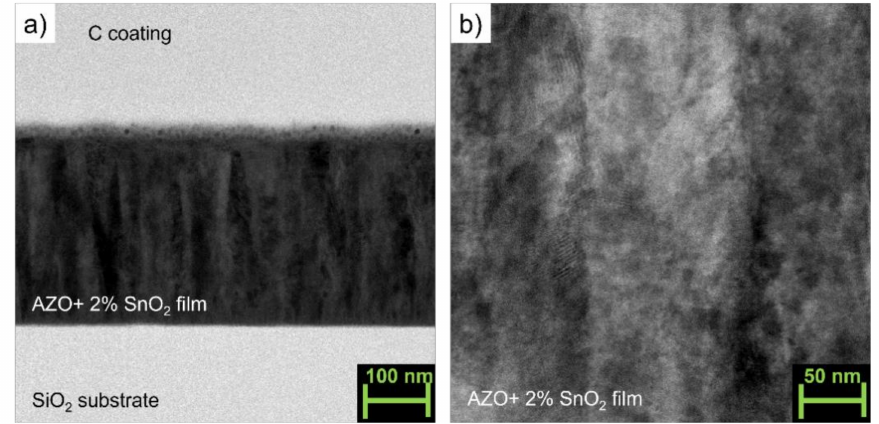
Figure 3. ( a ) Cross-sectional TEM image (magnification 150,000) of the AZO/silica thin film AZO_2S; ( b ) double magnification (300,000 × ) taken in the central zone of Figure 3a.